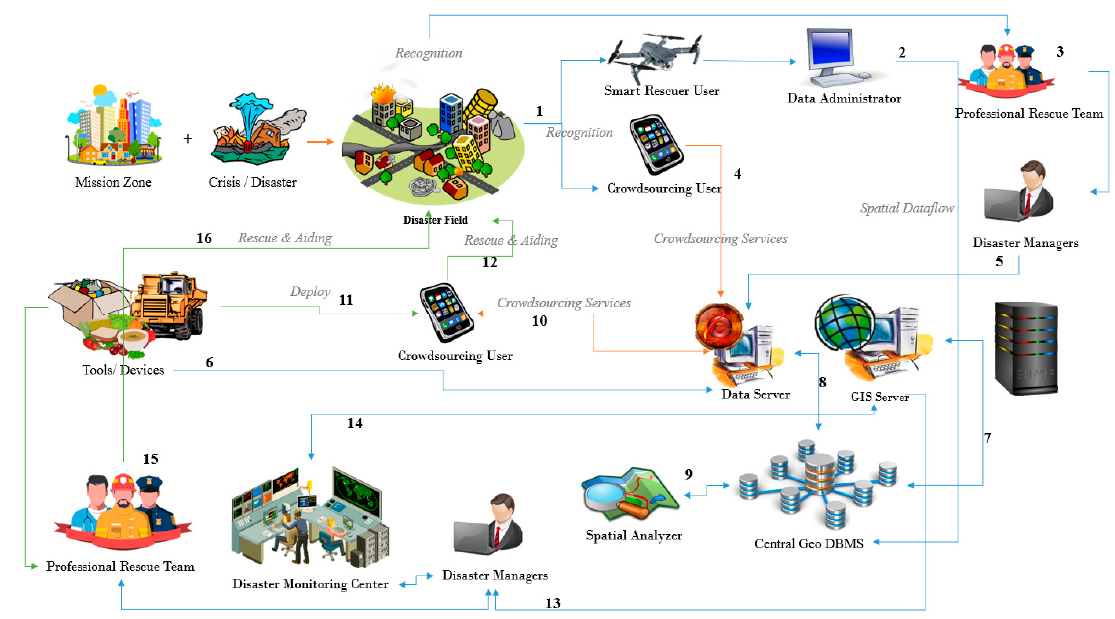
Figure 8. Programming in constructing the agent.